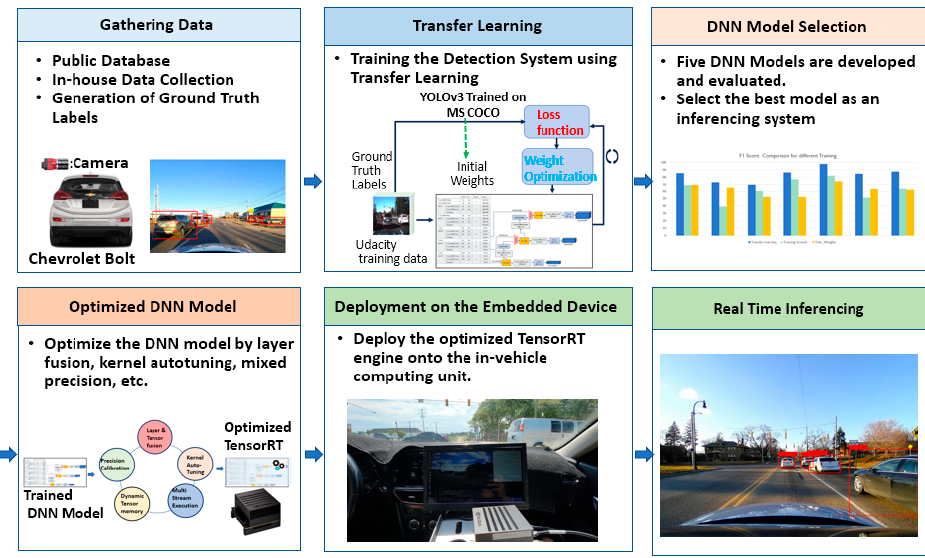
Figure 1. The overall architecture of the real-time inferencing system on the in-vehicle embedded